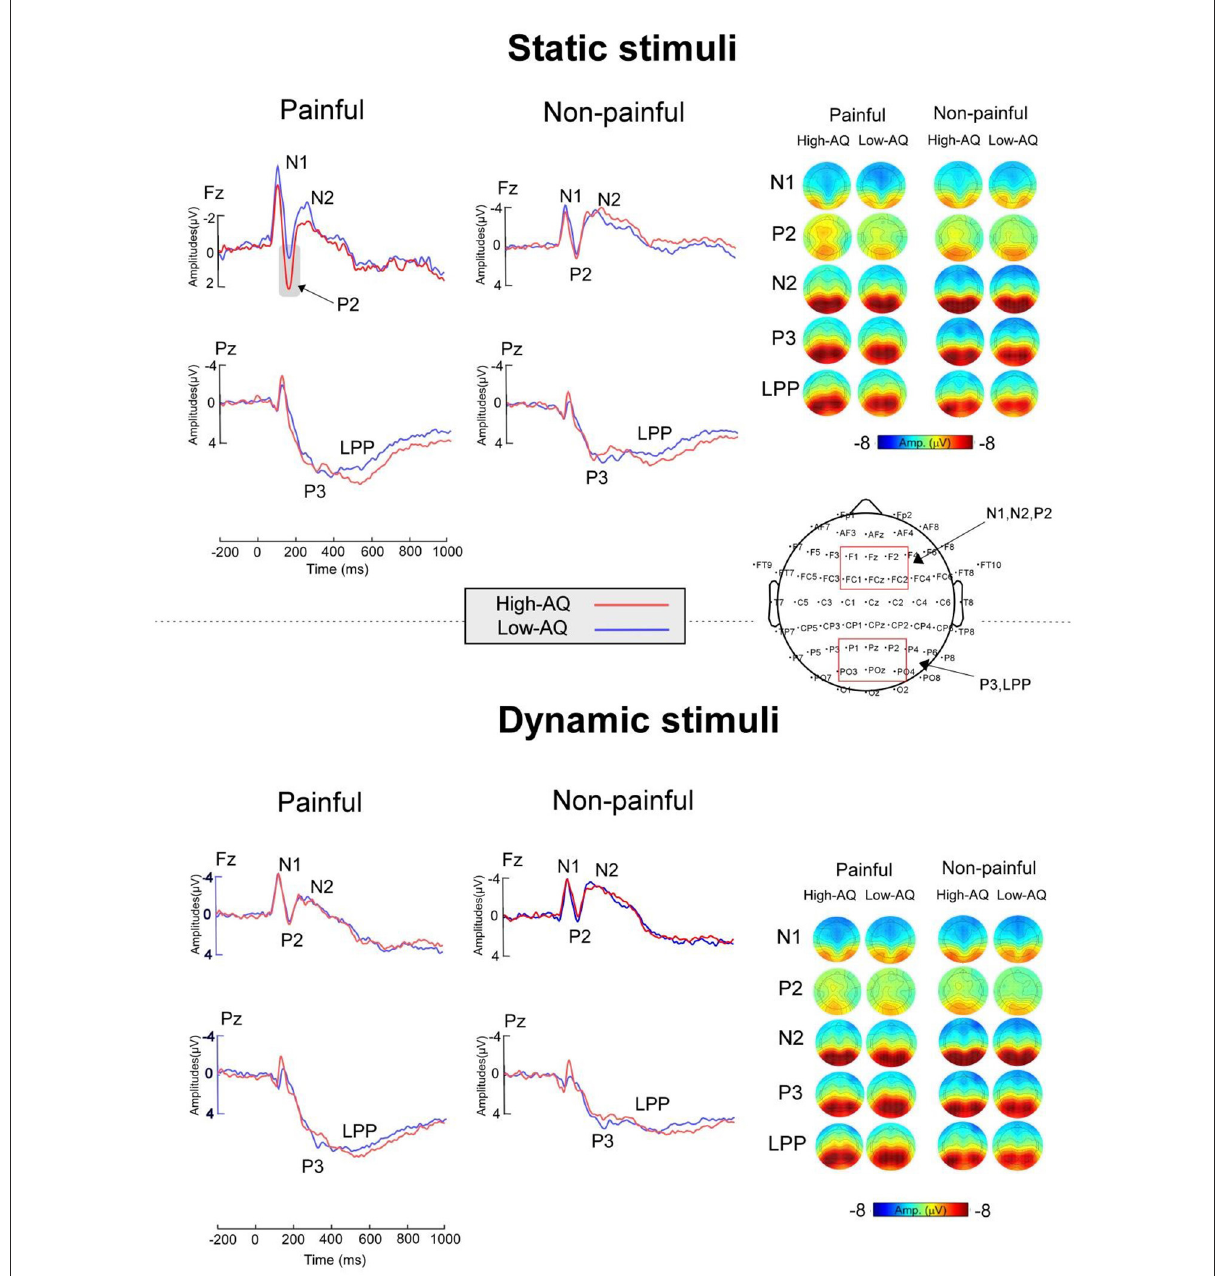
FIGURE3 ERP waveforms (Right) and scalp topography distributions (Left) exhibited by the High-AQ (blue lines) and Low-AQ (red lines) groups in response to static stimuli (Top) and dynamic stimuli (Bottom) . Electrodes used to estimate the ERP amplitudes are marked using the red squares on their respective topographic